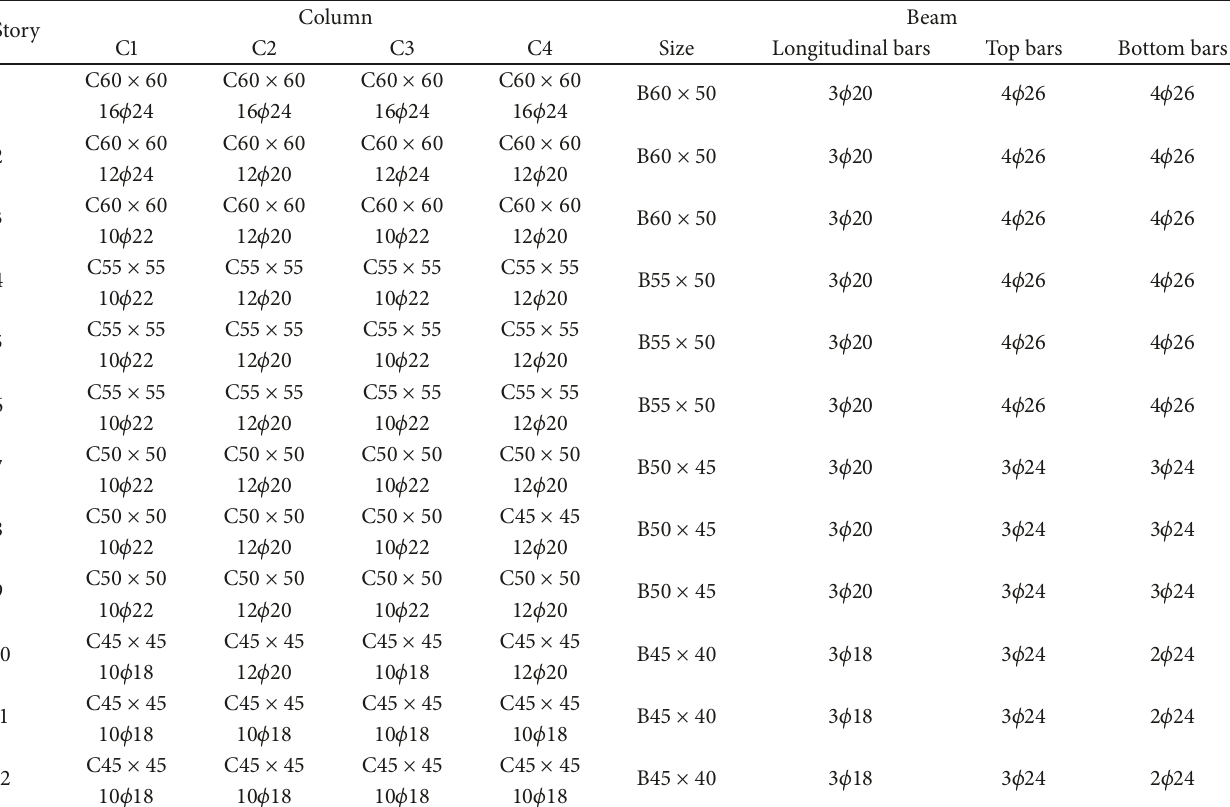
Table 7: Sections for the 12-story RC frame.